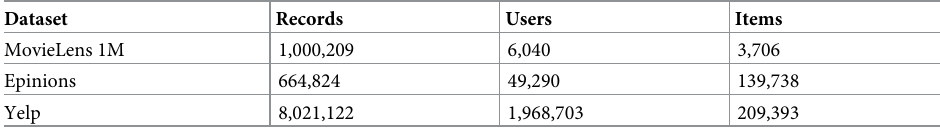
Table 2. The number of records, users, and item in each dataset. Dataset